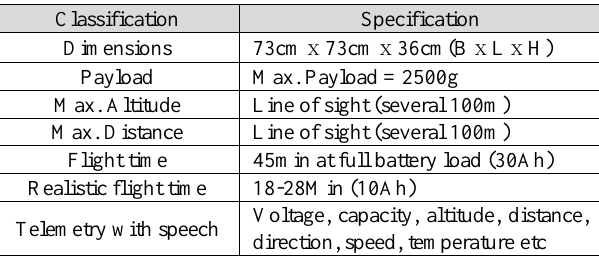
Table 1. Technical specifications of the UAV platform